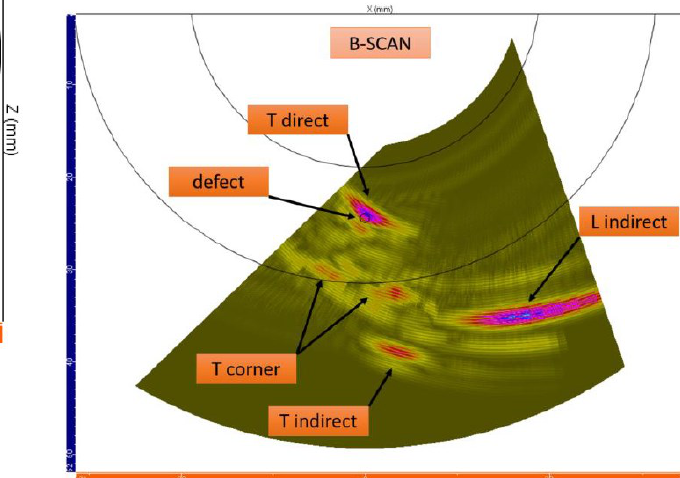
Fig. 8. T45° radiated beam, mode conversion on the back-wall and on the defect.